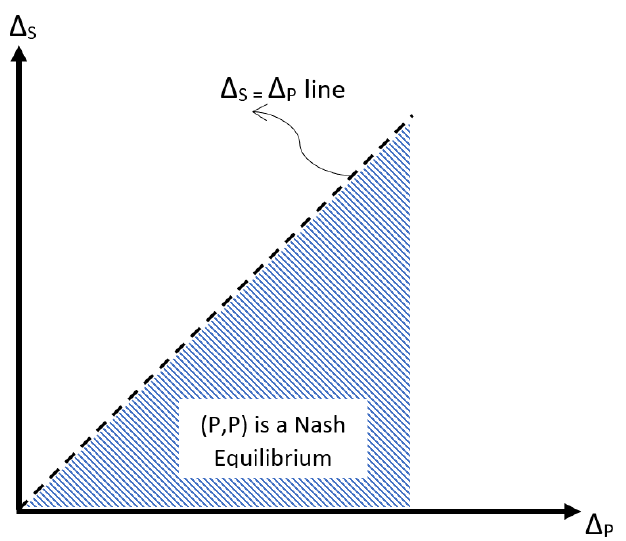
Figure 2. Equilibrium diagram for the S – P game with parameters ∆ S and ∆ P